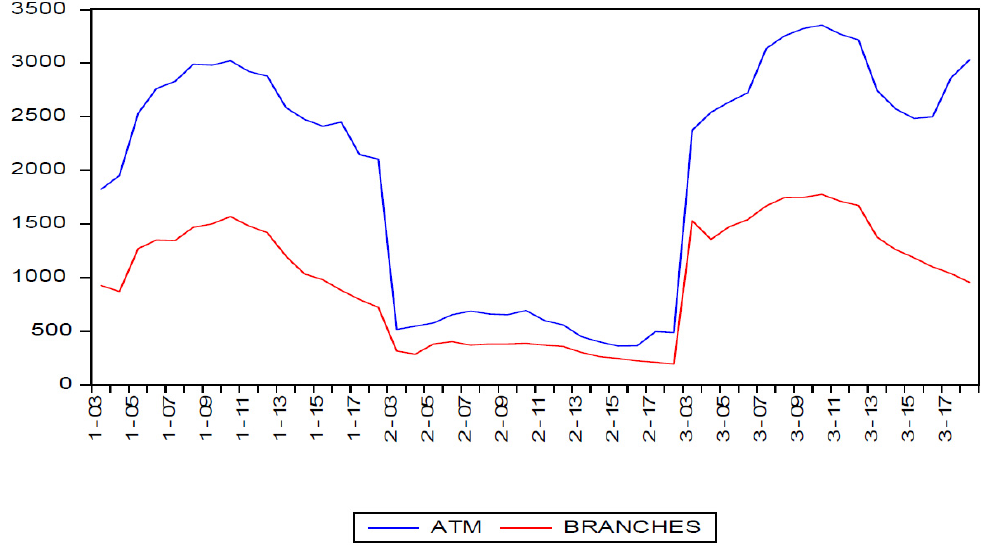
Figure 1. ATM and Branches per region / year (2003–2018). Notes: Region 1 (Athens), Region 2 (Thessaloniki), Region 3 (Other Areas—the rest of Greece). Source of data: Hellenic Bank Association.